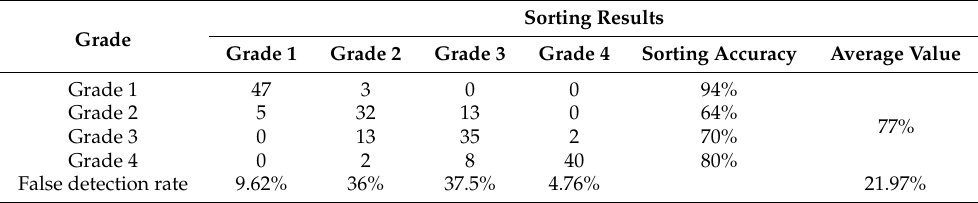
Table 4. Sorting accuracy and false detection rate of the system under dynamic